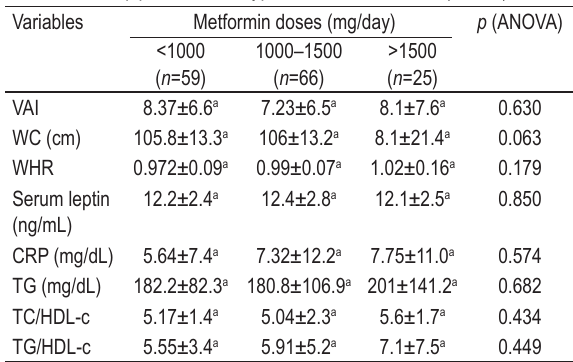
TABLE 3. Effects of up‑titrating metformin doses on the anthropometric markers, serum leptin and C‑reactive protein levels, and lipid profile markers of Iraqi patients with type 2 diabetes mellitus ( n =150)